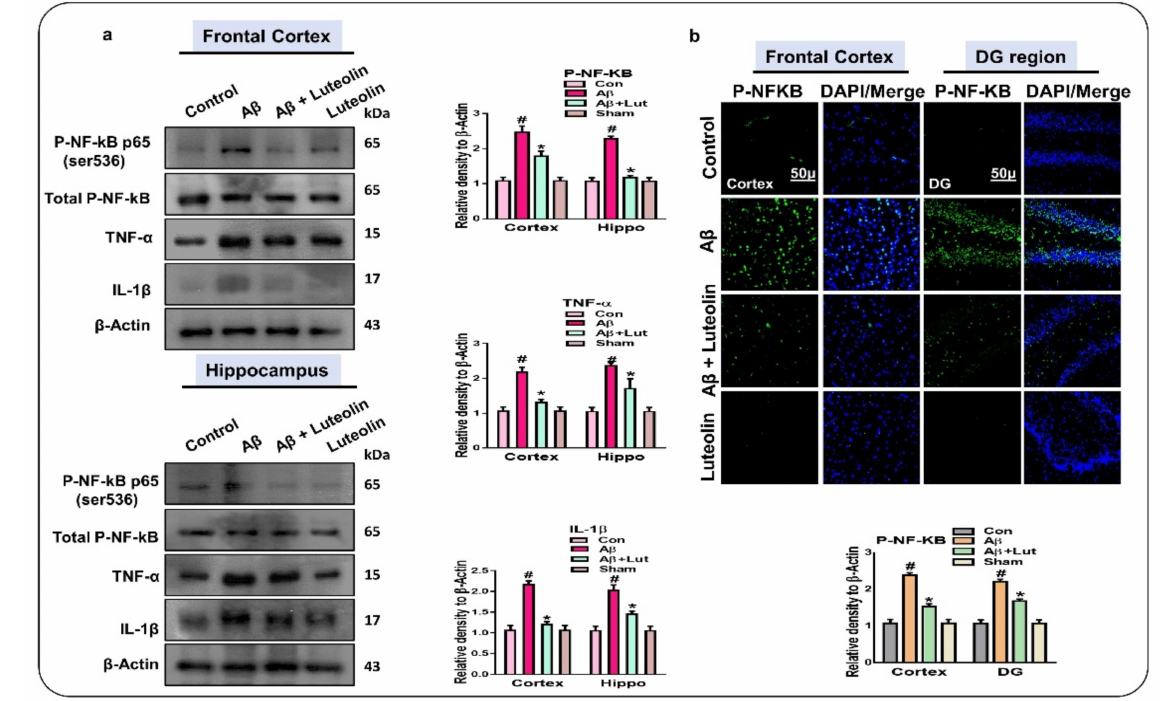
Figure 3. Luteolin ameliorated the activation of p-NF-kB p65 (Ser536) and of inflammatory mediators in the brains of A β 1 – α , and IL-1 β in the frontal cortex and hippocampus 42 -treated mice. ( a ) Western blot results of p-NF-kB p65 (Ser536), TNF- of experimental mice’s brains. β -Actin was used as a loading control. ( b ) Immunofluorescence results of p-NF-kB p65 in the frontal cortex and DG region of the hippocampus in experimental mice. Values are given as mean ± SEM from three independent experiments. Magnification 10 × . Scale bar 50 µ m. For the statistical analysis, Graph Pad Prism 5 software was used, and one-way ANOVA and posthoc multiple comparison tests were employed. * p < 0.05 represents control versus A β -treated mice, # p < 0.05 represents A β + Luteolin-treated